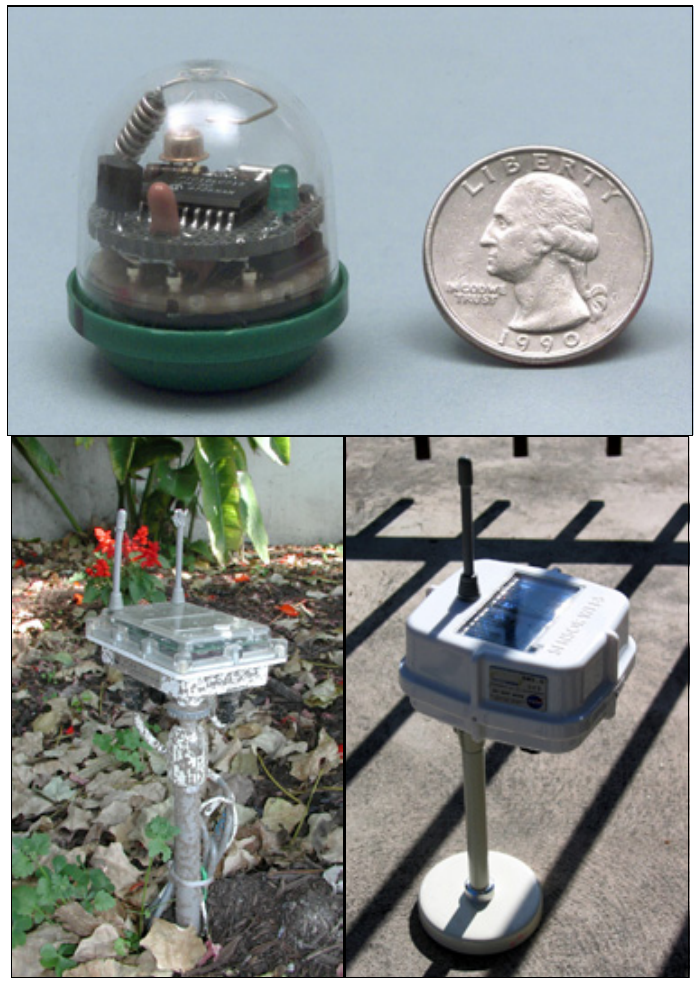
Figure 3. Various Sensor Web pods. Top: Functioning Sensor Web 1.0 pod, circa 1998. Note the small size which includes antenna, battery, and temperature and light sensors. Bottom Left: Sensor Web 3.1 pod deployed at the Huntington Botanical Gardens, circa 2002. It is about the size of two decks of playing cards. The pod is mud spattered from rain and watering and has a chewed